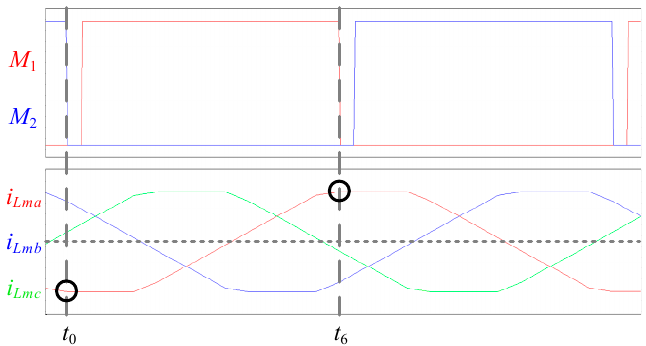
Figure 13. Waveform of symmetrical magnetizing inductor current.